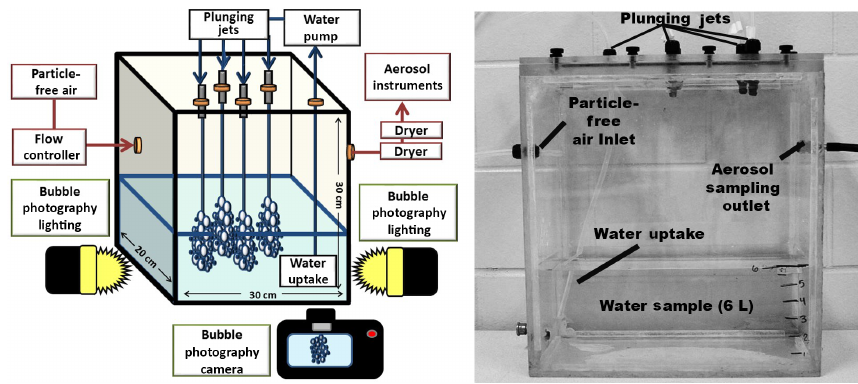
Figure 2. The constructed lake spray aerosol generator shown as a (a) schematic and (b) photograph with functional components labeled. Not all components of the LSA generator shown in the schematic are visible in the